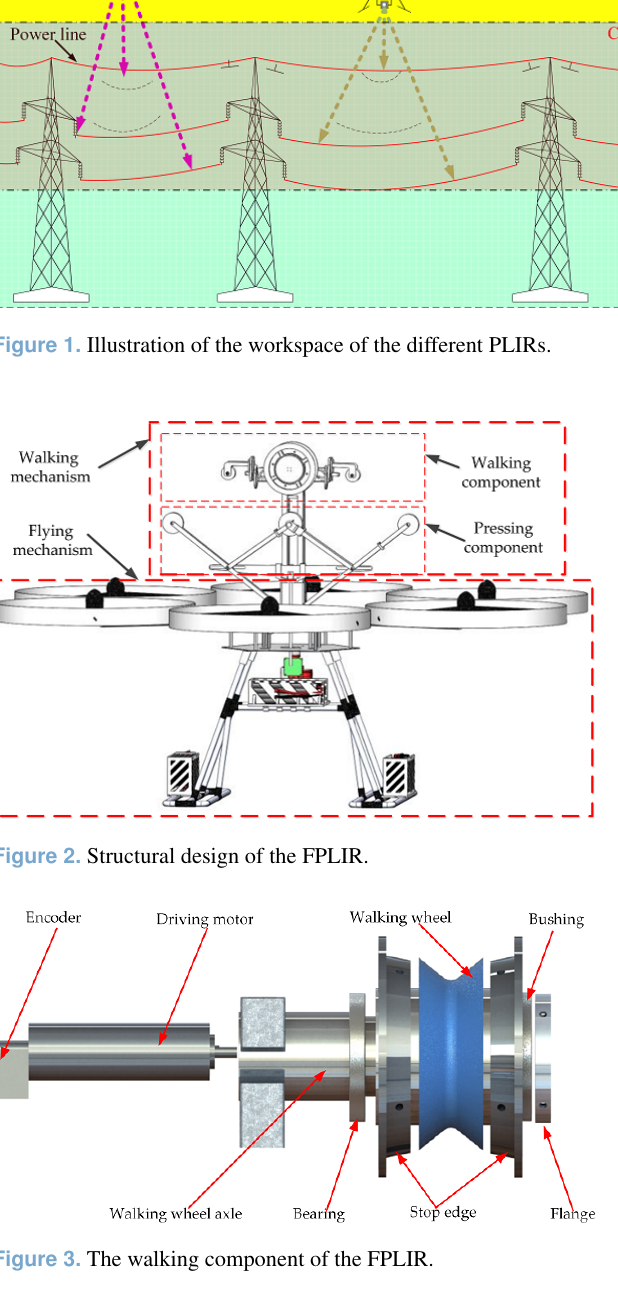
The undercarriage assembled of carbon fiber tubes is in- stalled at the bottom of the controlling box to bear the weight of the FPLIR and provide installing locations for three bat- teries. The function of the flying mechanism is to land on and off lines and to cross obstacles (e.g., tower and crossing wire